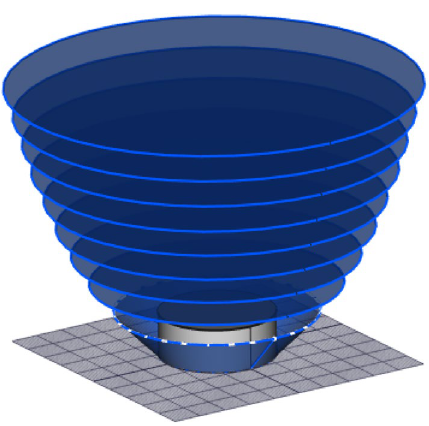
Figure 13. Space point layers confined within the collection volume of a FRT.